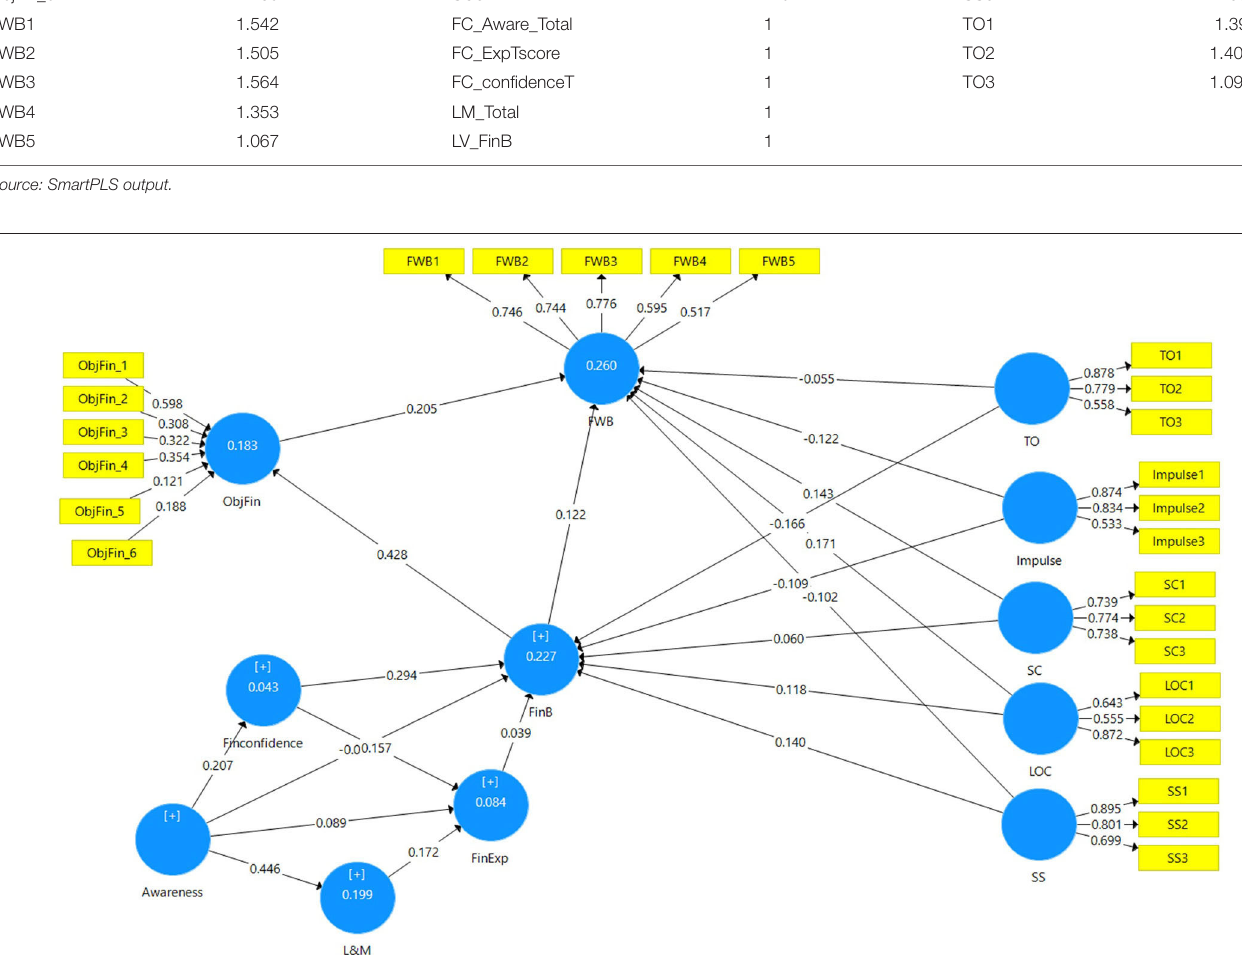
constructs with an omission distance of seven have a non- negative and above zero value, establishing the predictive relevance of the